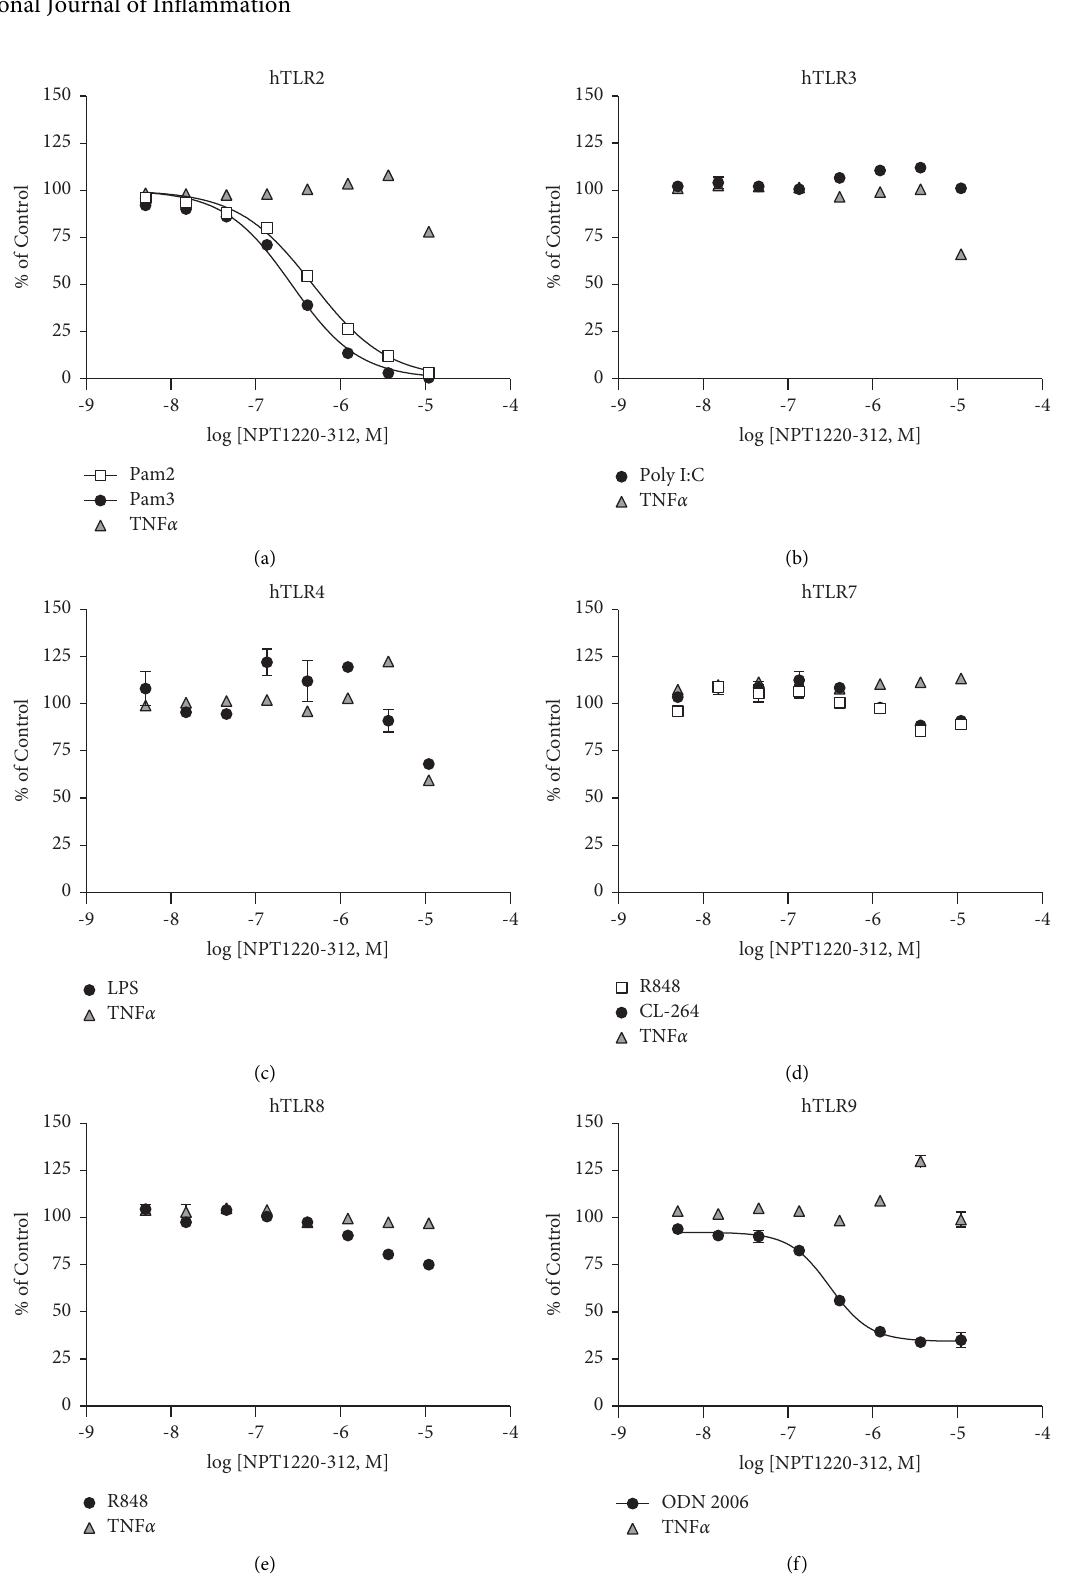
3 CSK 4 and TLR2/6